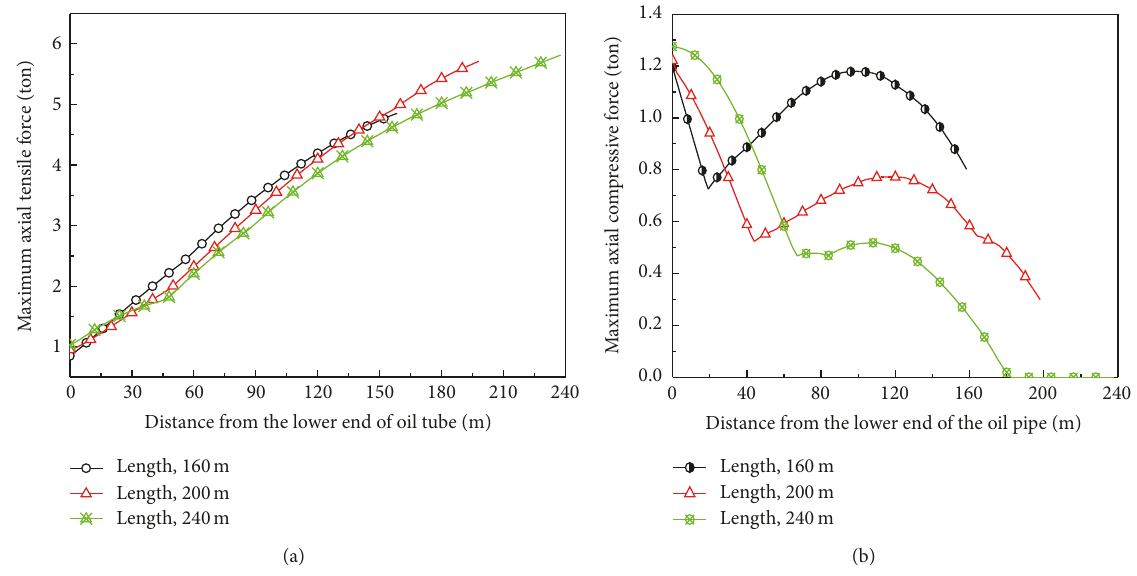
Figure 14: Effect of tube length on maximum dynamic axial force: (a) tensile force; (b) compressive force.